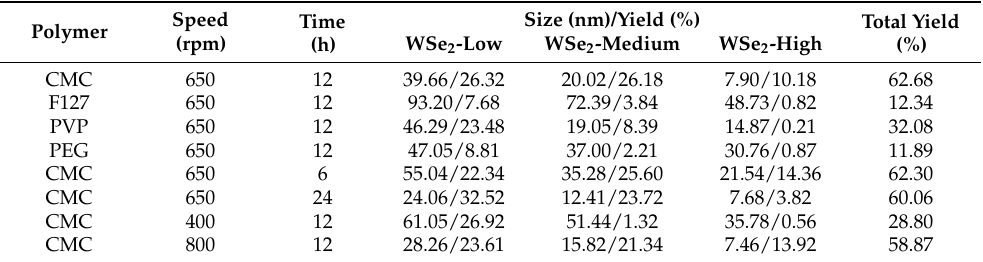
Table 1. Average lateral size and yield of WSe 2 NSs prepared by polymer-assisted ball milling under different experimental